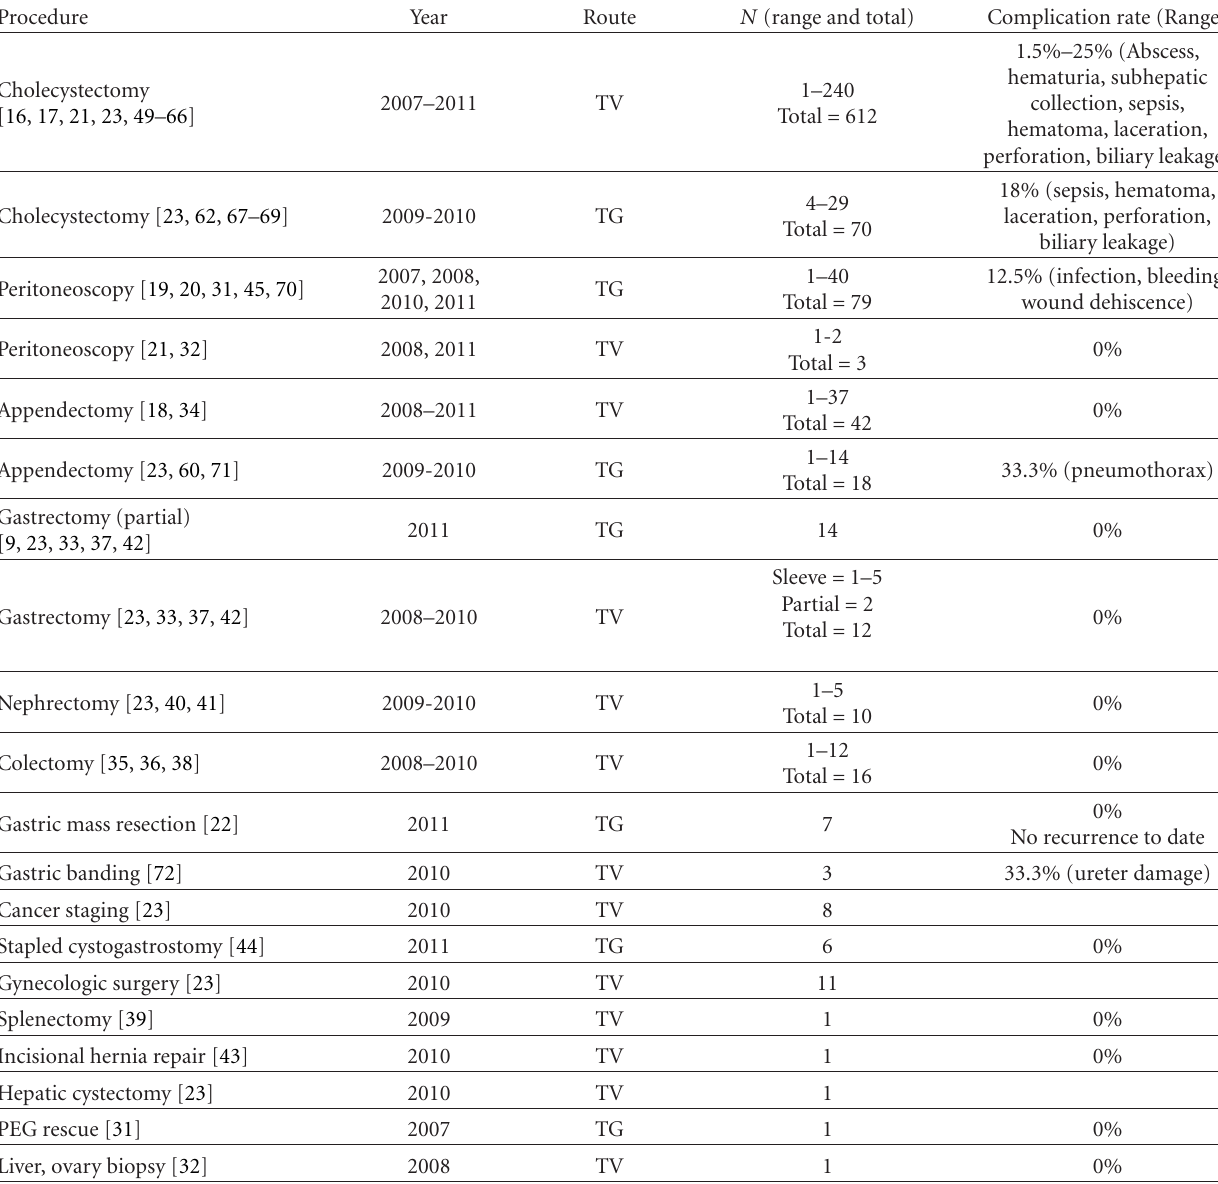
Table 1: Published NOTES studies in human populations between 2007 and 2011, grouped by